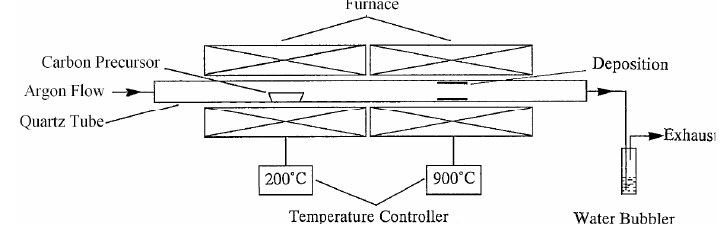
Figure.3 . Schematic diagram of a CVD